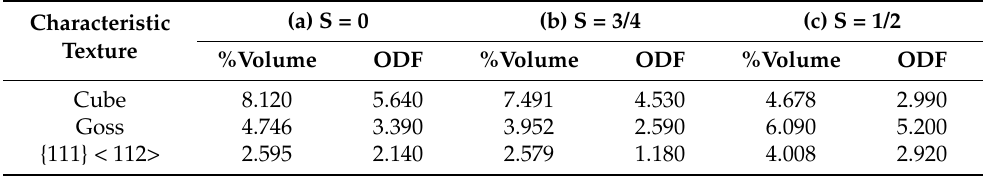
Table 2. The volume and ODF value of characteristic annealing texture (deviation ≤ 15 ◦ ) of